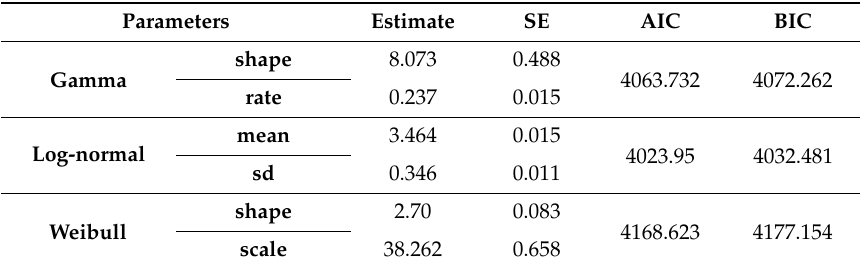
Table 3. Parameter estimates of probability distributions of SAS.